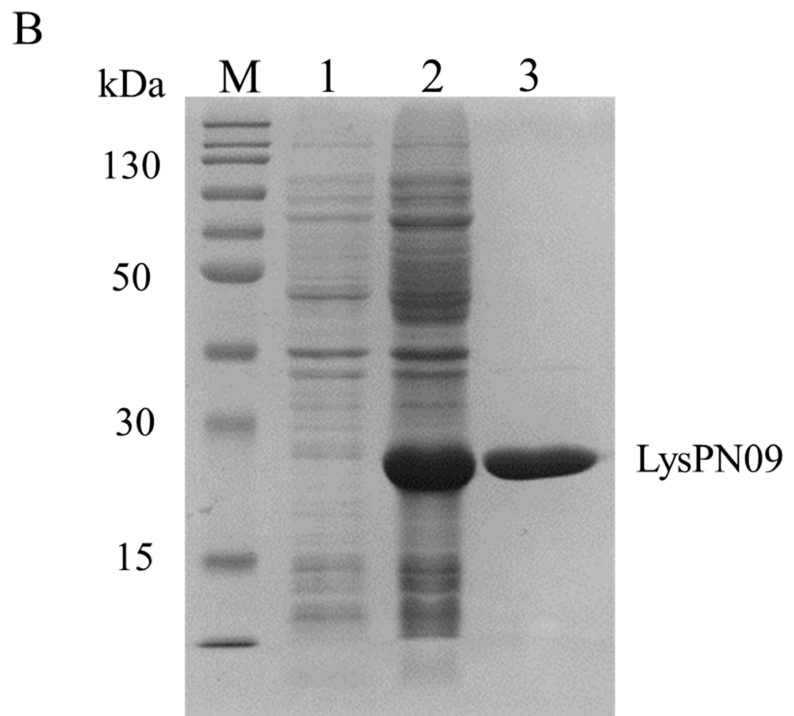
Figure 5. Expression and characterization of LysPN09, the endolysin in the lytic phage PN09. ( A ) The domain organization of LysPN09. ( B ) SDS-PAGE analysis of LysPN09. Lane M, molecular weight marker. Lane 1, un-induced lysate extract of BL21(DE3). Lane 2, IPTG-induced bacterial lysate. Lane 3, purified recombinant LysPN09.